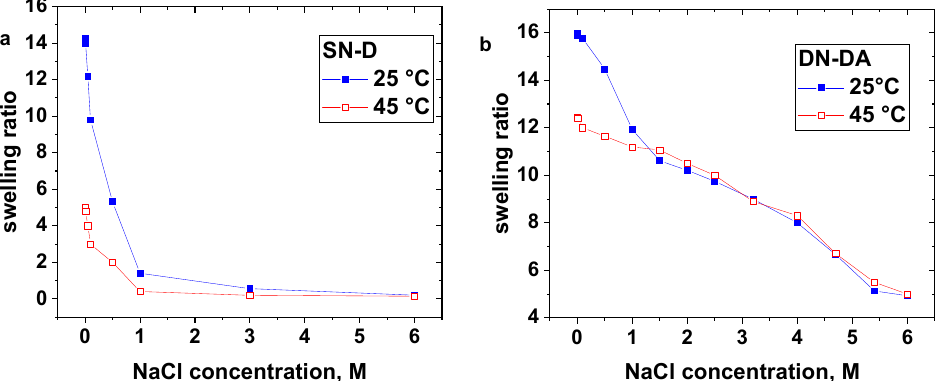
Figure 6. Dependence of the swelling ratio on the NaCl concentration for the SN-D ( a ) and DN-DA ( b ) hydrogels measured at two varying temperatures. ( b ) hydrogels measured at two varying